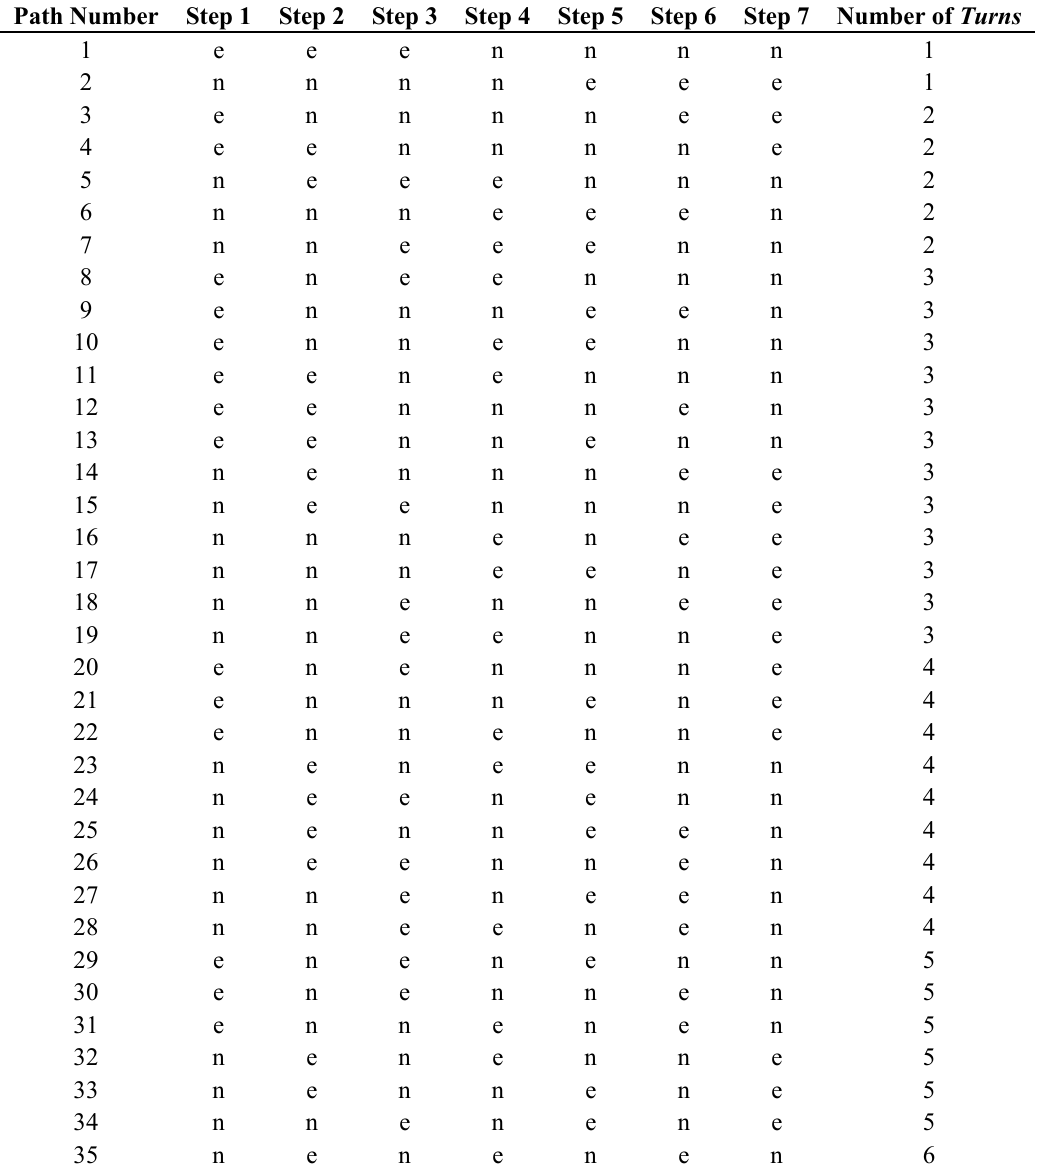
Table 2. All paths of the 2D lattice L (3,